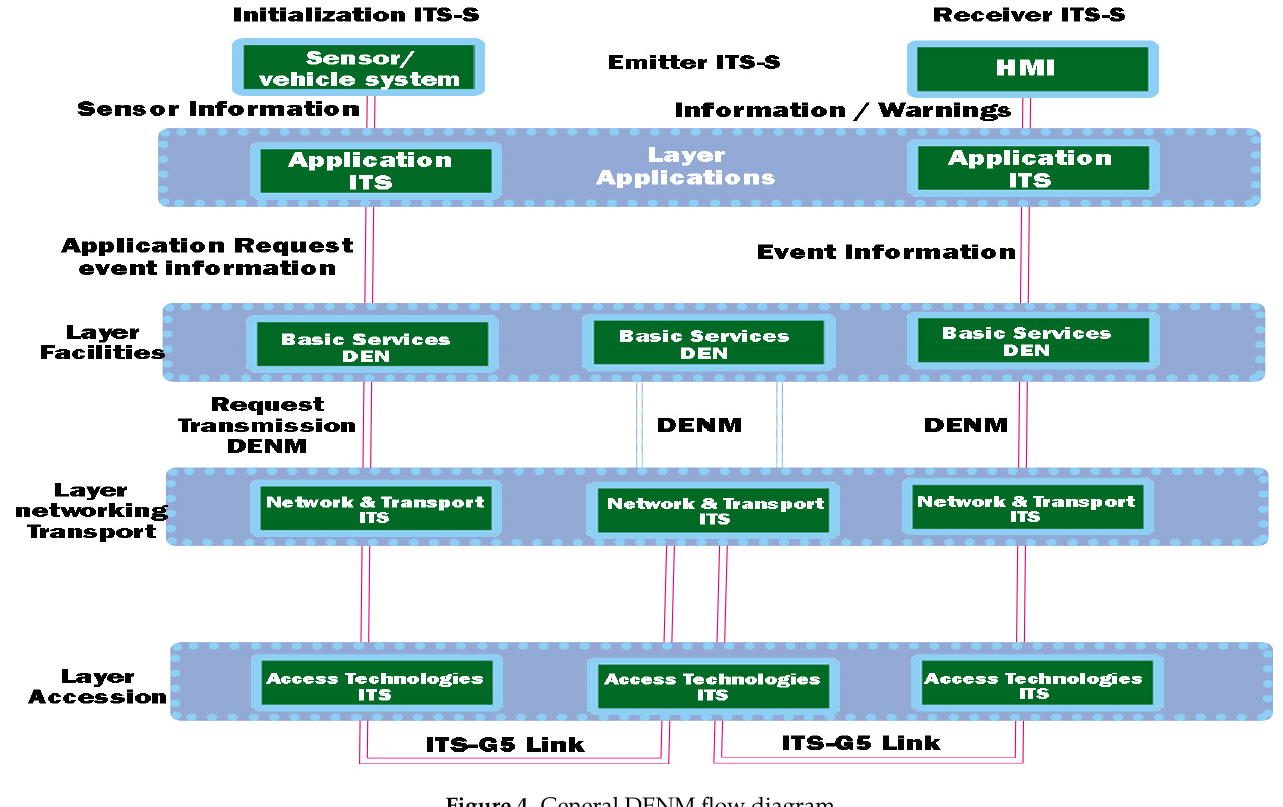
Figure 4. General DENM flow diagram.